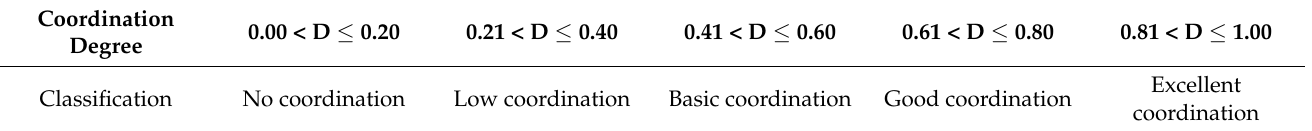
Table 4. The classification of the CCD.